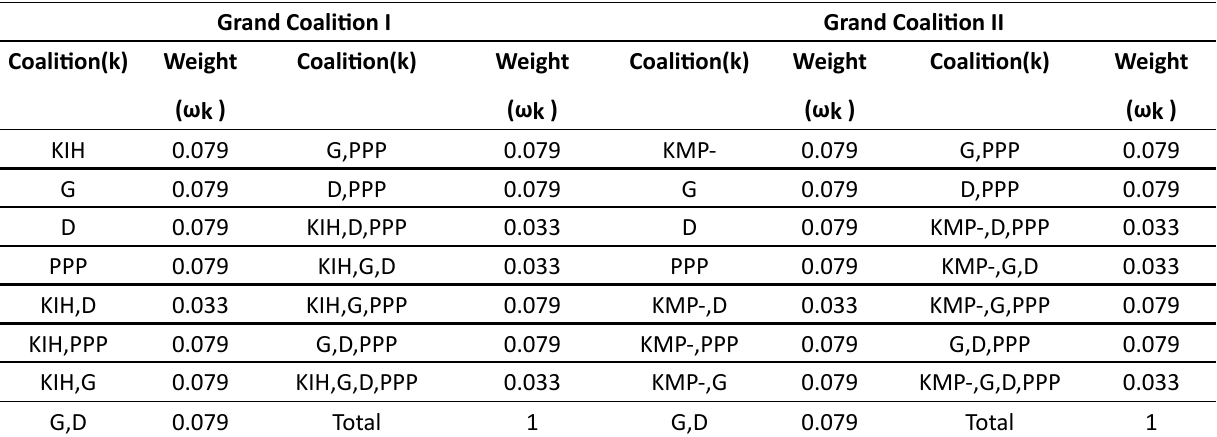
Table 2: Coalitional Weight